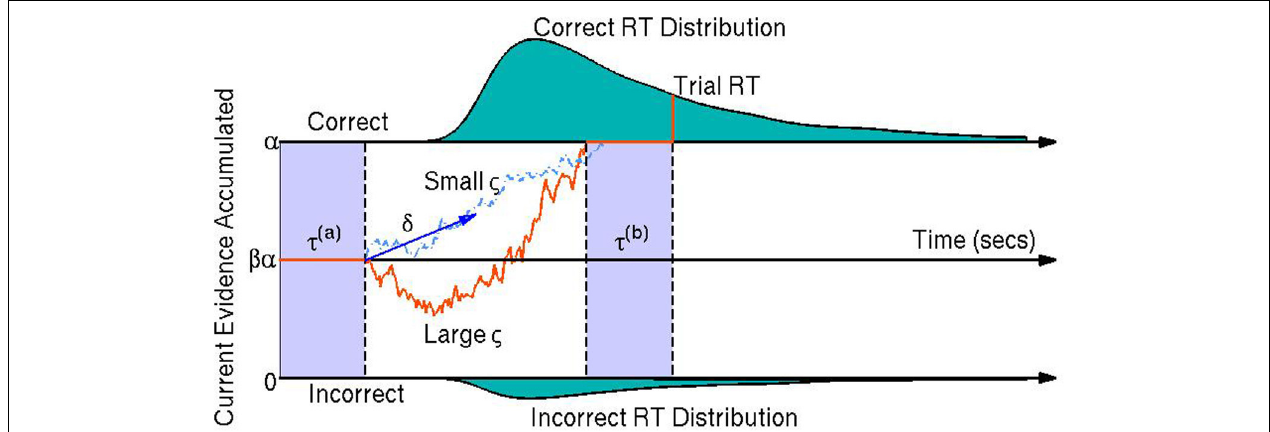
FIGURE 1 | A visual representation of the diffusion model. The orange line represents the participant’s stochastic evidence accumulation process during one trial. When a participant accumulates enough evidence over time for a correct or incorrect response (graphically represented by the top and bottom boundaries at 0 and α , respectively) a decision is made. The drift rate δ is the mean rate of evidence accumulation (evidence units per second) during the participant’s decision time on one trial. The bias parameter β represents a bias of the participant toward one choice or the other (set to 1 2 when the model parameters are expressed in terms of correct over incorrect evidence instead of choice A over choice B evidence). The non-decision time τ is the portion of the participant’s reaction time (RT) during the trial not associated with decision making, equal to the sum of encoding/preprocessing time τ ( a ) and motor response